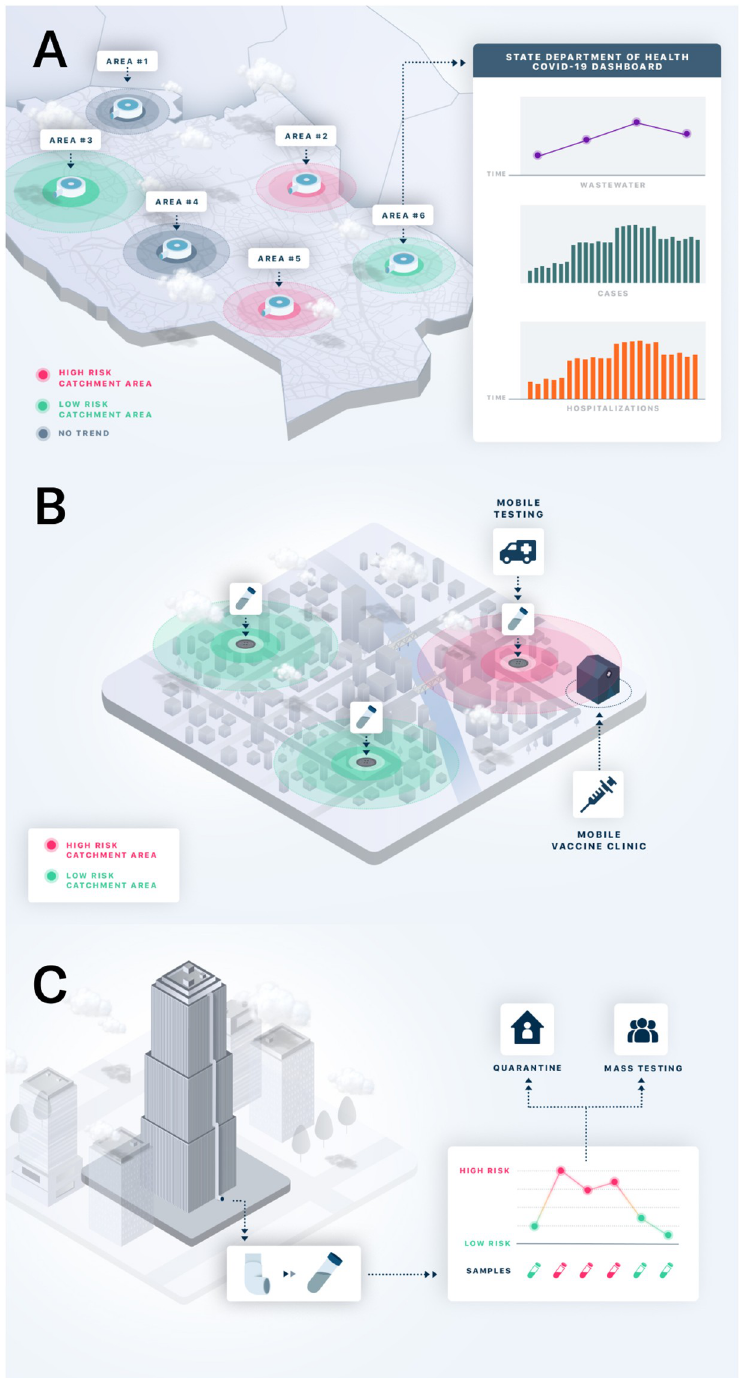
Fig 1. Implementation of WBE at three geographic scales: (A) wastewater treatment plant level, (B) neighborhood level, and (C) building level. With permission from Biobot Analytics.